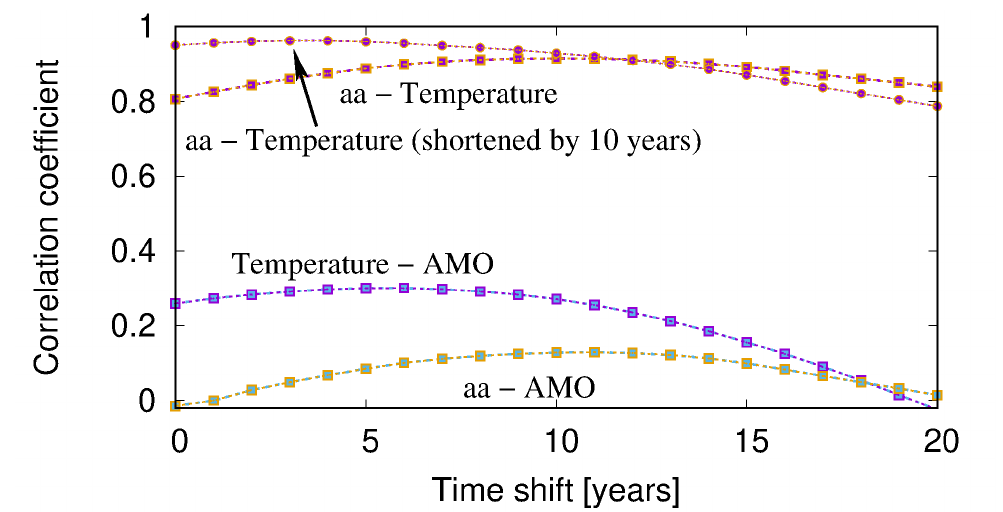
Figure 3. Correlations between various data, each representing a 23-year centered moving average, in dependence on the time shift δ t between them. In each case, the first item indicates the earlier dataset, the second the later one. The aa- ∆ T correlation starts at a value r = 0.8 for δ t = 0 and reaches a maximum of r = 0.915 for δ t = 10years. While this might insinuate a 10-year causal time shift between aa index and ∆ T , it is more likely connected with the canceling effect of the latest decade with its poor correlation. In the second curve, for which we completely omitted the last 10years of both data, we obtain r = 0.95 at δ t = 0, increasing to a maximum of r = 0.962 at δ t = 3years. Compared to those large r -values, the correlation of ∆ T and AMO is much smaller, viz 0.3 at δ t = 6years (AMO lagging behind temperature). The correlation of aa index and AMO is still smaller, with a maximum of r = 0.129 for δ t =